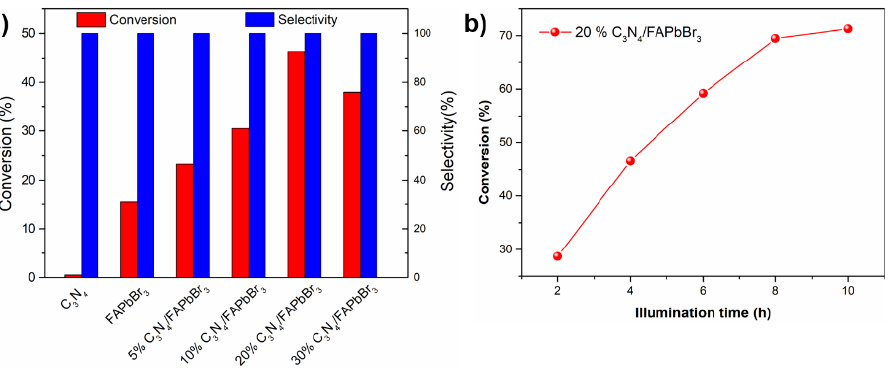
Figure 4. ( a ) Photocatalytic oxidation of benzylic alcohol to benzaldehyde over pristine FAPbBr 3 /C 3 N 4 of different weight ratios, noted that the pure FAPbBr 3 is of ca. 3 µ m; ( b ) photocatalytic oxidation of benzylic alcohol using 20% FAPbBr 3 /C 3 N 4 under different illumination durations, the data is averaged from 3 individual tests. Reaction conditions: photocatalyst (10 mg) and 0.1 mmol reactant, in trifluorotoluene (1.5 mL) saturated with oxygen before experiments, irradiated by AM 1.5G (ca. 100 mW cm − 2 ) for 4 h each cycle, under room temperature. To further realise the photocatalytic process, electron spin resonance (ESR) spec- troscopy is exploited to confirm the photo-induced reactive oxygen species, under sim- ulated solar illumination. 5,5-Dimethy-1-Pyrroline N-oxide (DMPO) is employed as a trapping agent. Negligible signals from DMPO • • O 2 − is observed in absence of illumi-